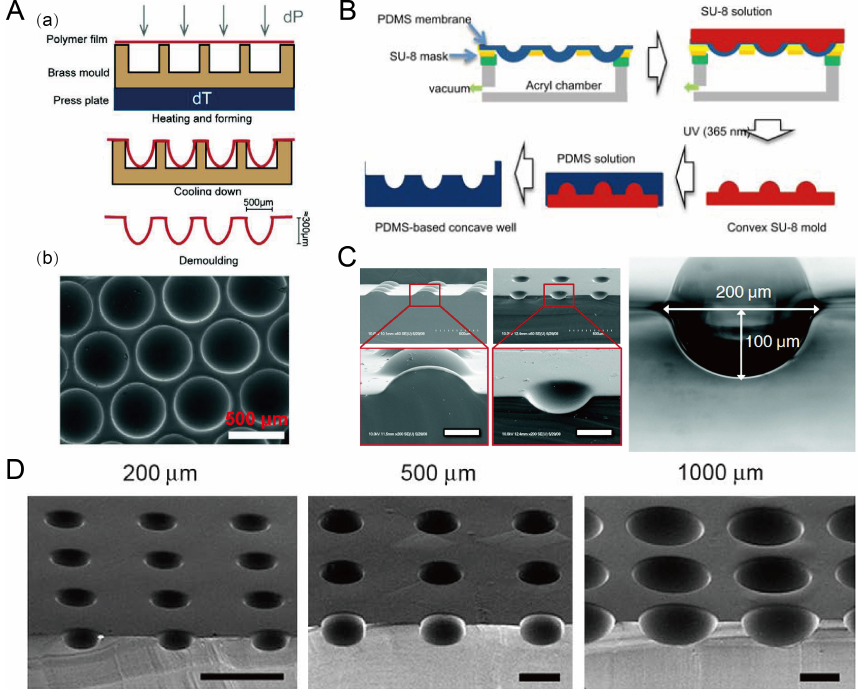
Figure 8. Concave microwells fabricated by methods utilizing deformed PDMS membranes. ( A ) A thin polycarbonate film was deformed by pressure and heat, and then was cooled down and demoulded (a) to obtain an array of concave microwells (b) [68]. Reprinted (adapted) from [68] under the terms of the Creative Commons Attribution-NonCommercial-NoDerivs License. ( B ) The fabrication of convex SU-8 mold: at first the PDMS membrane was deformed by vacuum, and then SU-8 was filled on the membrane and crosslinked. After that, the convex SU-8 mold was used to prepare PDMS replicas with concave microwells [71]. Reprinted (adapted) from [71]. Copyright (2011) with permission from Springer Nature. ( C ) SEM pictures of the convex SU-8 mold and concave microwells fabricated by a similar method as that described in ( B ) [69]. Scale bars: 100 µm. Reprinted (adapted) from [69]. Copyright (2009) with permission from Royal Society of Chemistry. ( D ) SEM pictures of the concave microwells of different dimensions fabricated by a similar method as that described in ( B ) [70]. Scale bars: 500 µm. Reprinted (adapted) from [70]. Copyright (2010) with permission from